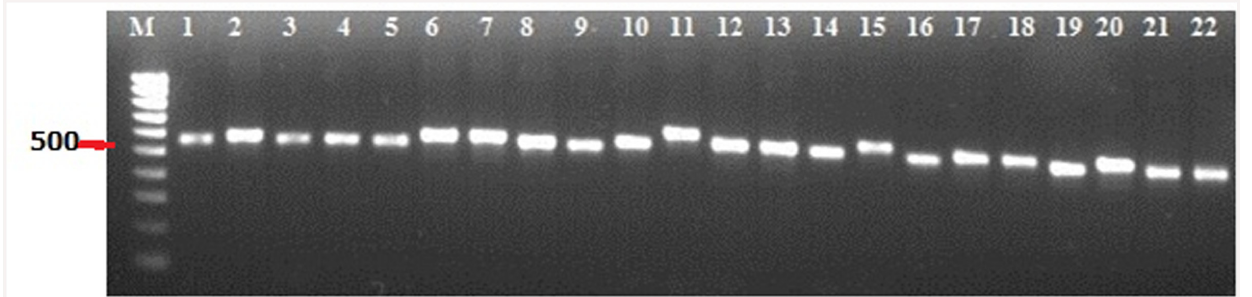
Fig 2. PCR products of approximately 550 to 600 bp of ITS region in endophytic fungi of C . roseus . Lane M: 100-bp DNA marker. Lanes 1 to 22: PCR products of CrP1 to CrP22.